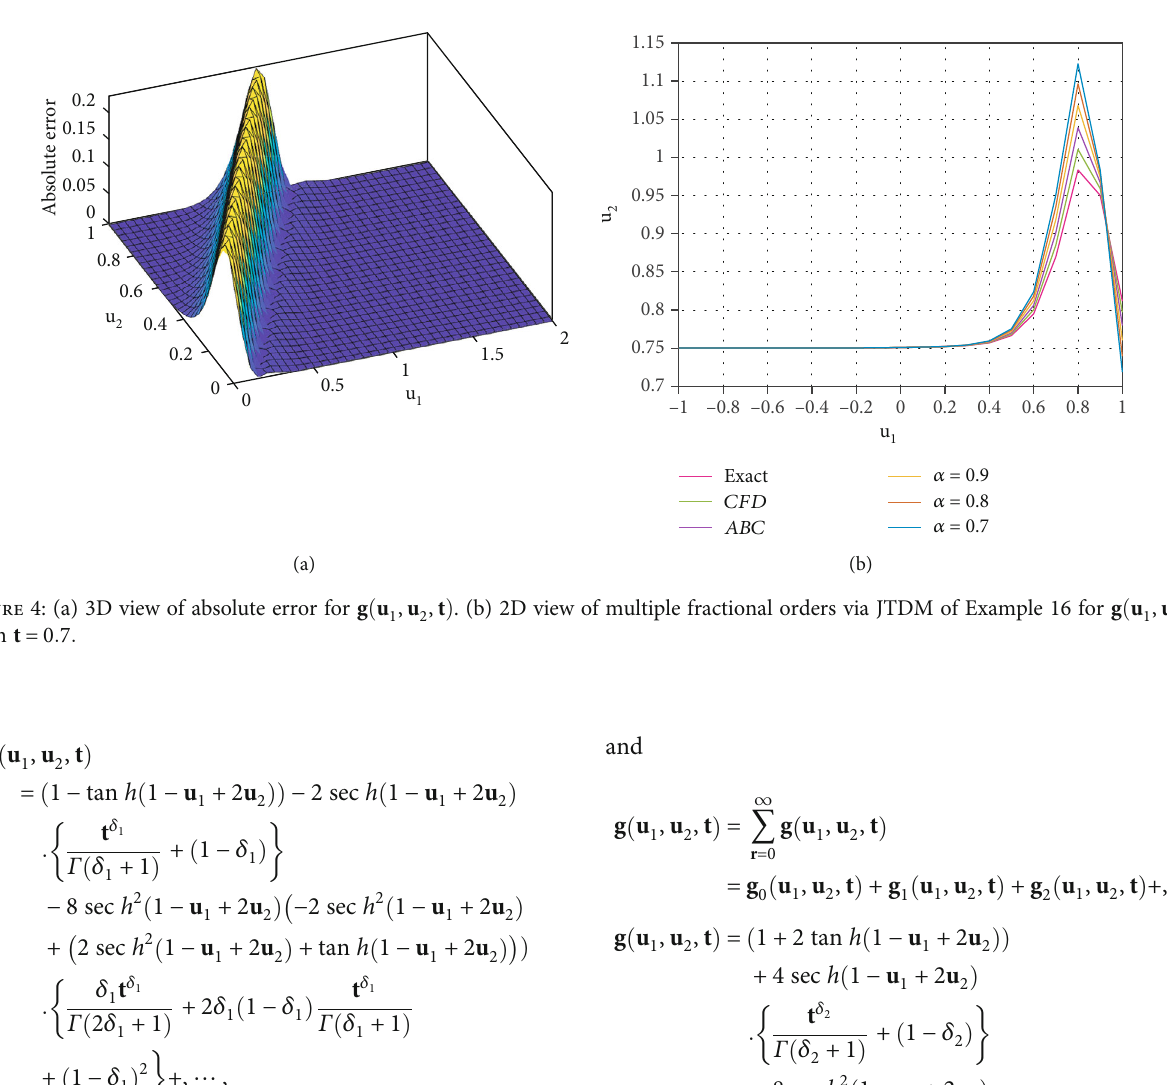
u t Þ when δ 1 , 2 , 2 = 1